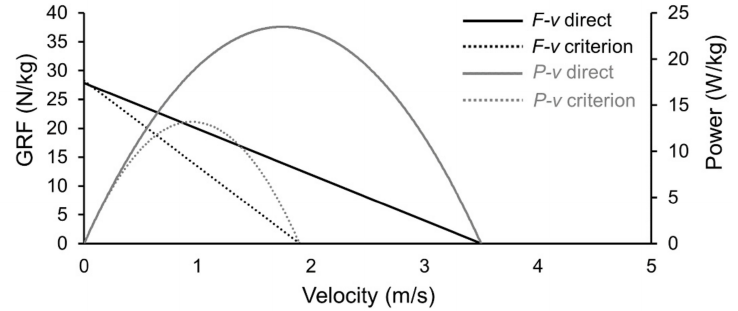
Figure 4. Graphical presentation of average differences between force–velocity (linear lines) and power–velocity (hyperbolas) curves obtained from criterion (dotted curves, i.e., force plates and linear encoder) and direct (solid curves, i.e., rotary encoder) measures. Note that the Y-axis intercept represents maximal theoretical force (F0), X-axis intercept represents maximal theoretical velocity (V0), and the apex of the power–velocity curve represents the maximal theoretical power (P max ) when performing squats on the FW